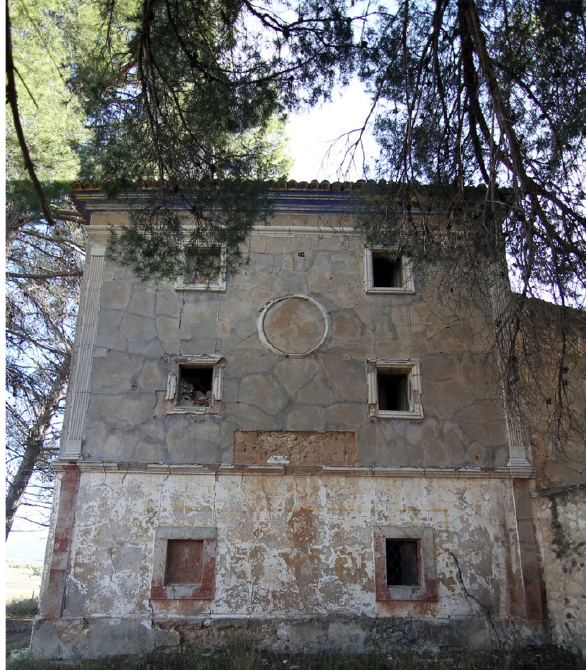
Figure 22. Composition of the west side façade.